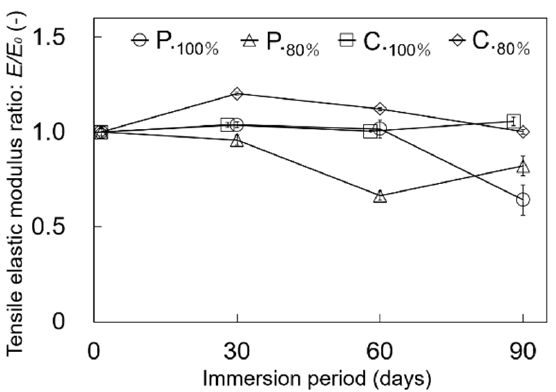
Figure 12. Comparison of the changes of the tensile elastic moduli of the four test piece types brought about by the immersion. Average ± S.D., N = 5.